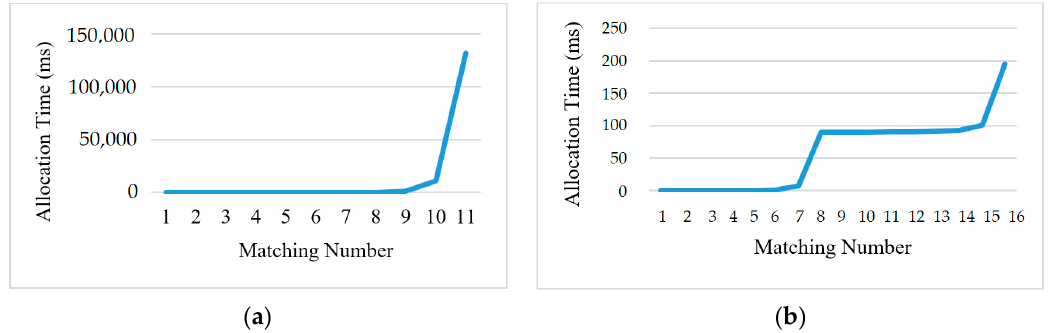
Figure 10. Assignment times by the number of matching. ( a ) The assignment time obtained without the classification. ( b ) When taken as ϕ = 8, assignment times obtained by K nearest neighbor (k-NN) classification.